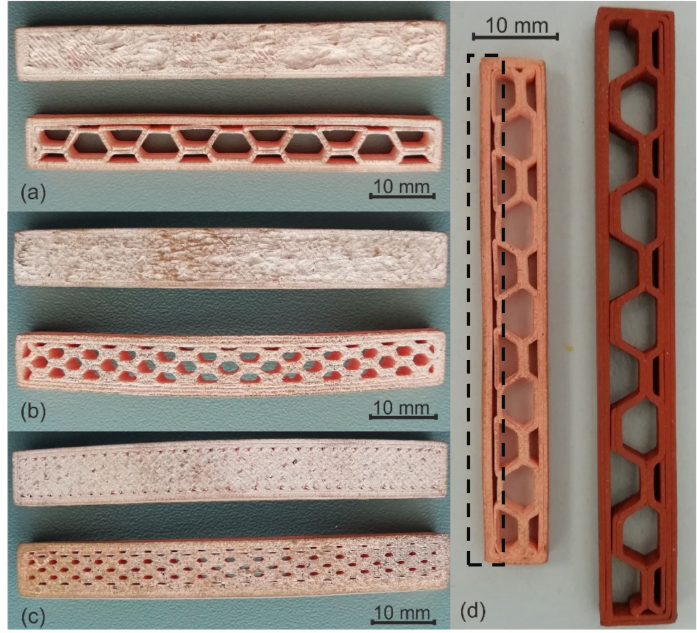
Figure 7. Sintered specimens with cover and without and different infill degree ( a ) 25%, ( b ) 50%, and ( c ) 75%. ( d ) Comparison between sintered and printed part. The dotted rectangle highlights the delamination between the infill and the